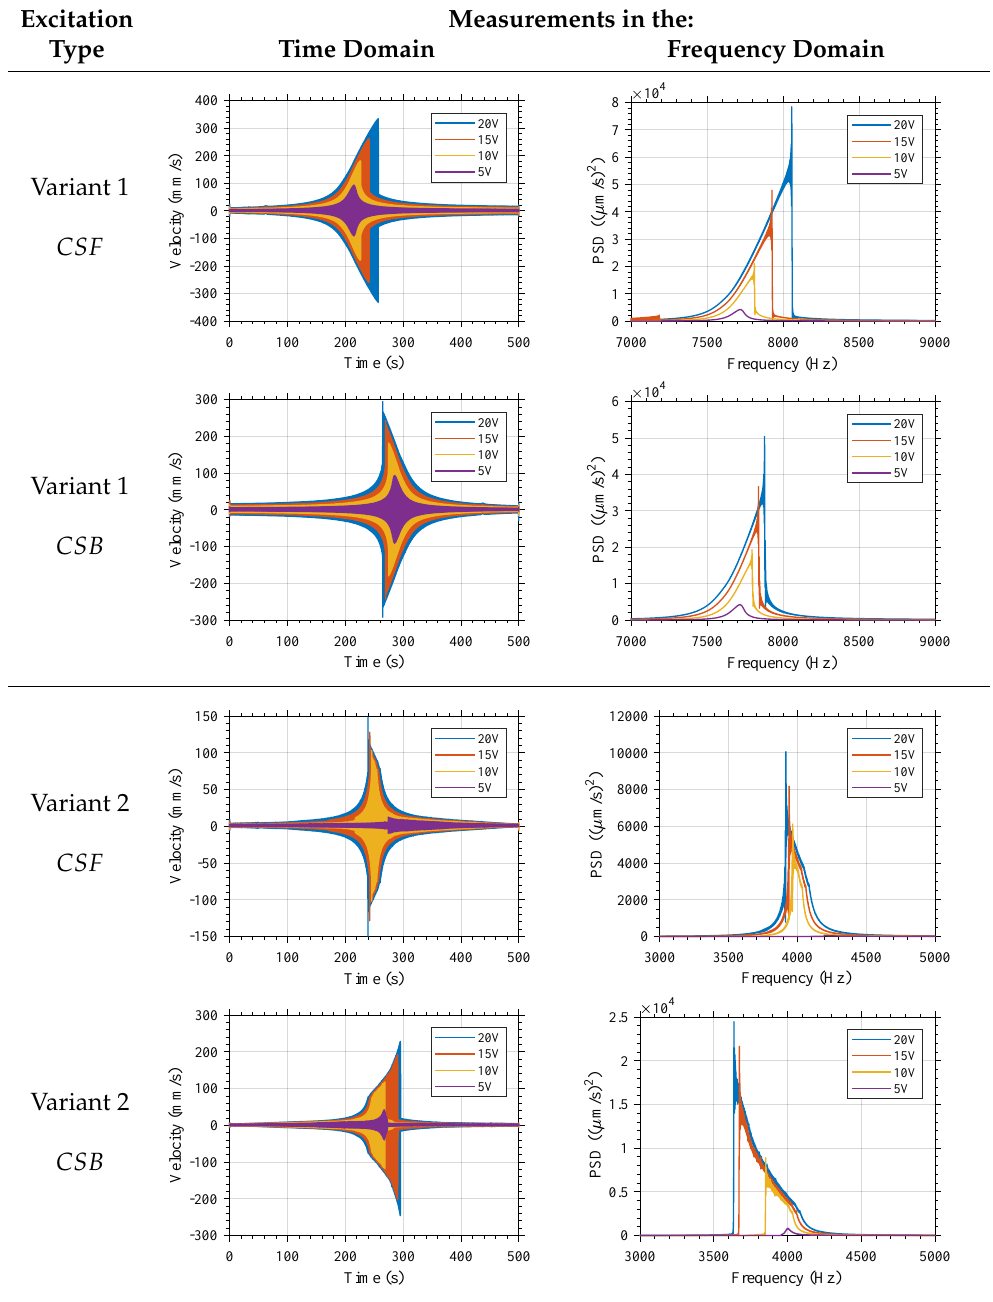
Table A2. Summary of the measurements results for the CS -type